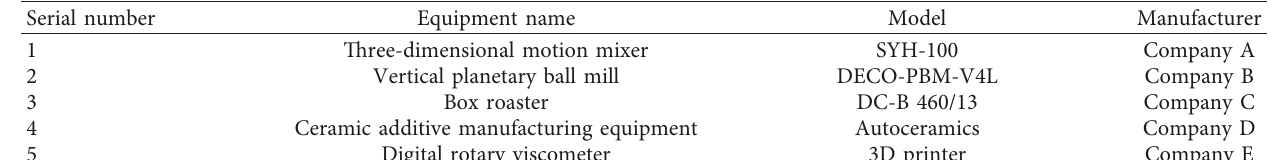
Table 2: Equipment used in the